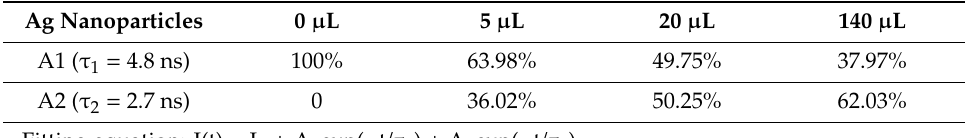
Table 1. The fitting results of fluorescence decay curves of iLOV protein with various quantities of 29 nm Ag nanoparticles